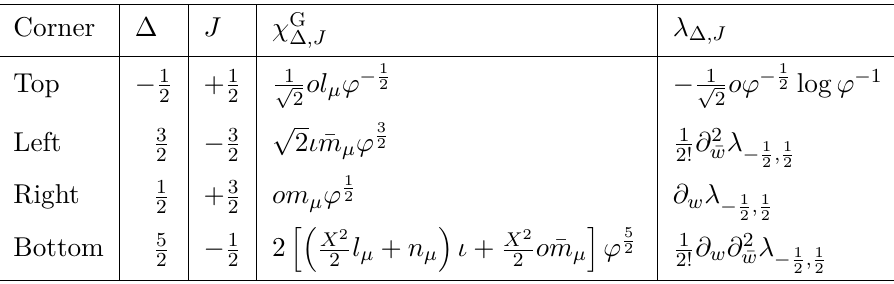
Table 14. Elements of the celestial diamond corresponding to large supersymmetry.